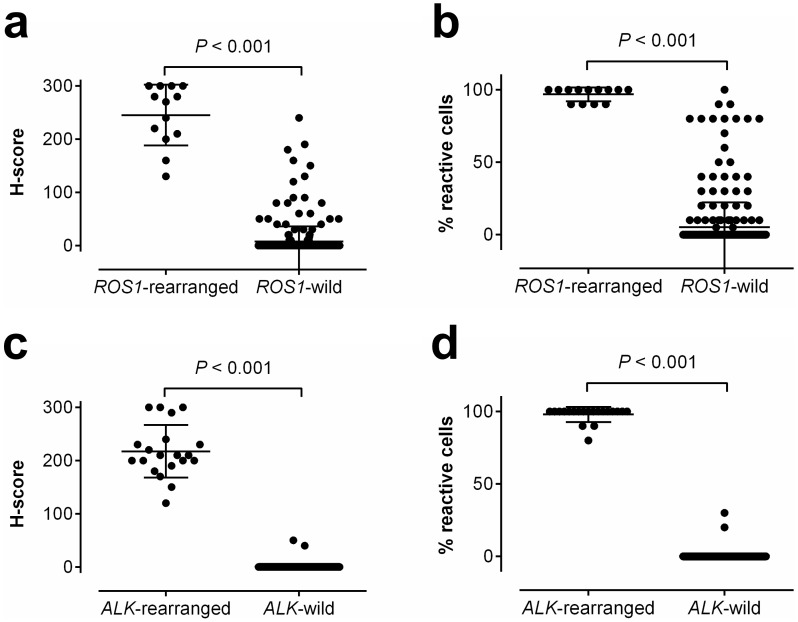
Comparison of the H-score and extent of ROS1 (a, b) and ALK (c, d) immunoreactivity in gene-rearranged vs. non-rearranged tumors.Scatter dot plots for H-scores (a, c) and percentage of immunoreactive cells (b, d) show significantly increased expression of each protein in rearranged tumors (p<0.001). All rearranged tumors show an H-score of more than 100 and extent of more than 75%.